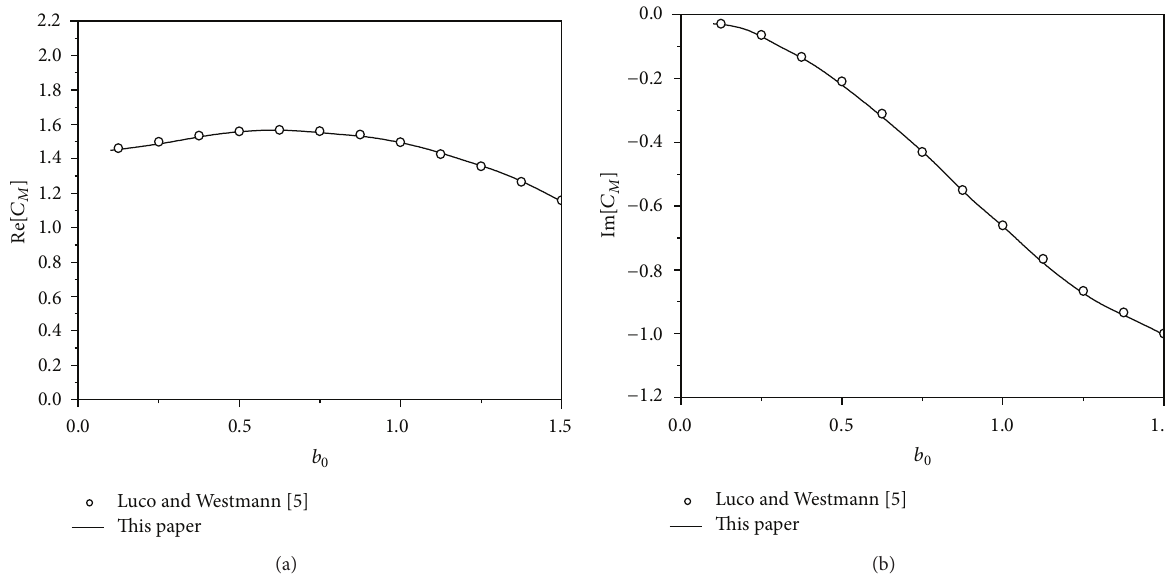
Figure 2: The dynamic compliance coefficient versus the dimensionless frequency. (a) Real part of 𝐶 𝑀 versus the dimensionless frequency and (b) imaginary part of 𝐶 𝑀 versus the dimensionless frequency.